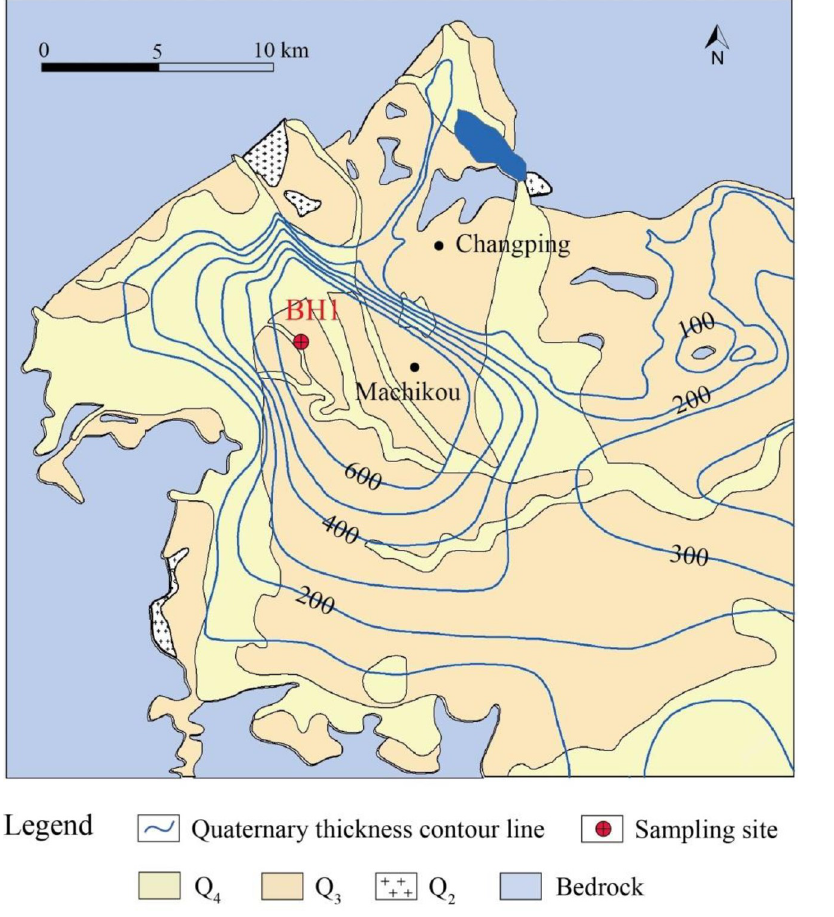
Fig 1. Geological map of the study area (sampling site is located in the borehole BH1).